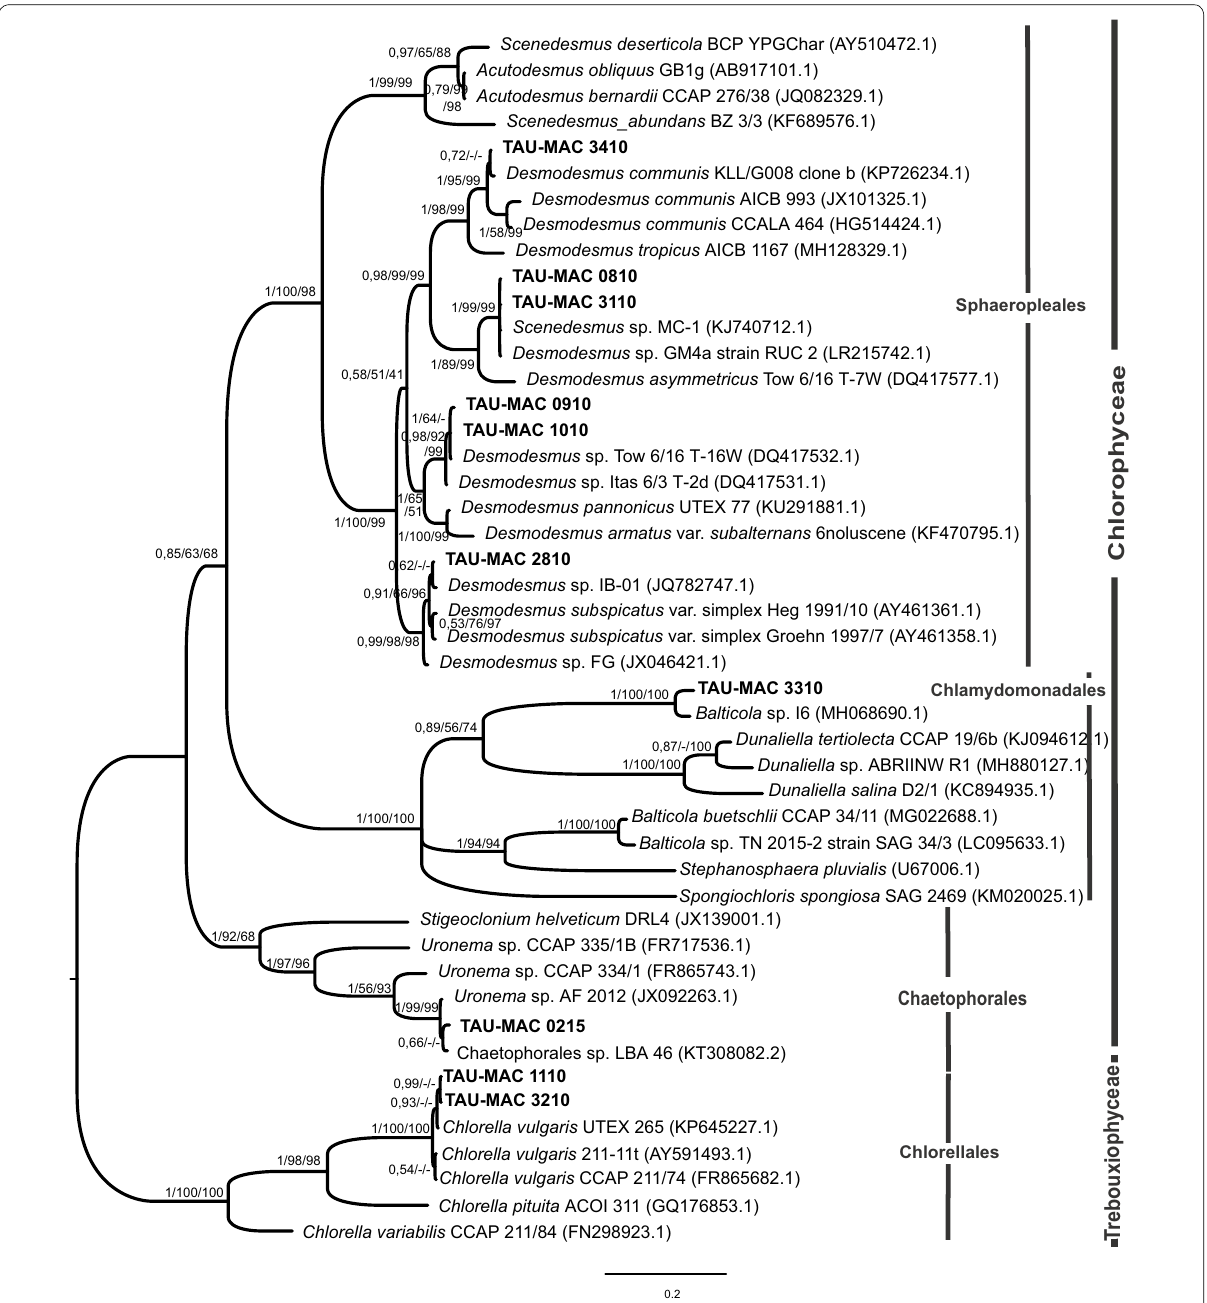
Fig. 4 Bayesian inference (BI) phylogenetic tree of relationships of internal transcribed spacer 1 and 2 (ITS1/TS2) rDNA (c. 700 bp) of green algae including the classes Chlorophyceae and Trebouxiophyceae. Support values are indicated as posterior probability for BI and bootstrap support for maximum likelihood (ML) and maximum parsimony (MP) analysis (BI/ML/MP). The numbers in parentheses are GenBank accession